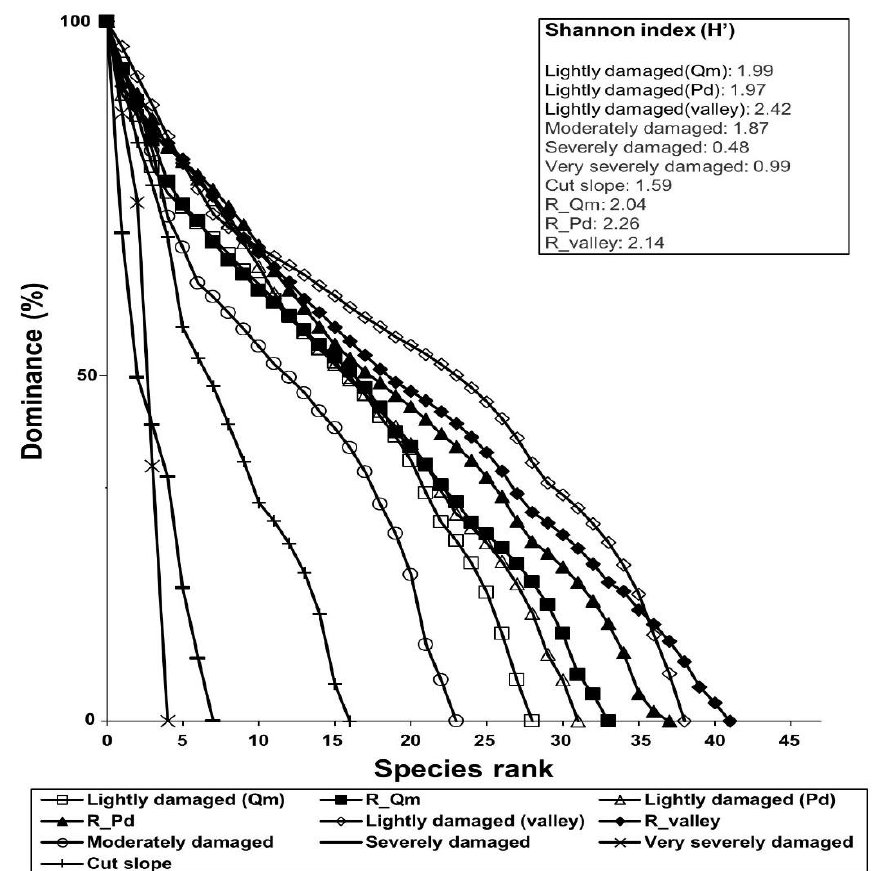
Figure 9. Species rank–dominance curves of vegetation stands established around the Seokpo smelter and on the natural reference forest, Uljin Forest Genetic Resources Conservation Reserve, southeastern Korea. Legends are the same as those in Figure